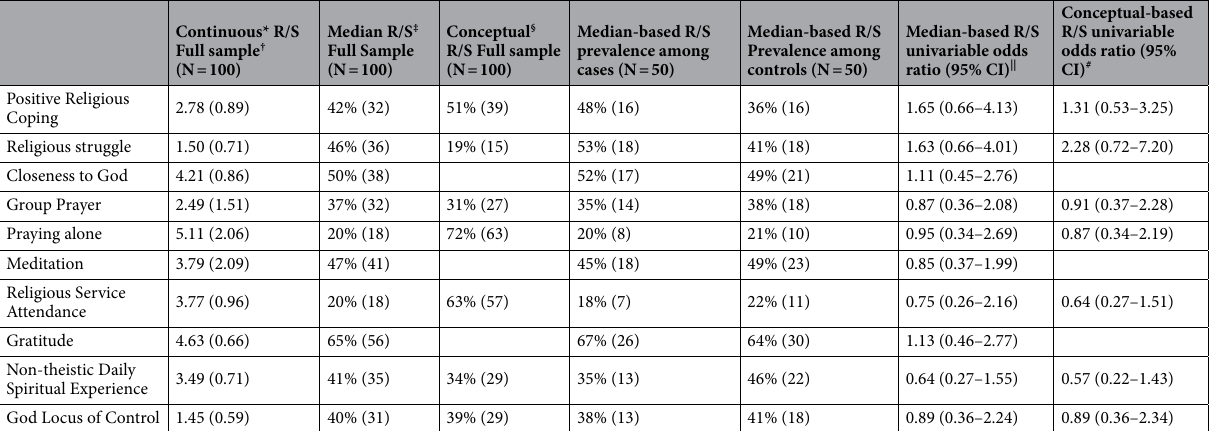
Table 4. Prevalence of R/S Variables and their Association with Incident CVD in the MASALA Study. *Mean (Standard Deviation). † Of the 100 subjects in the sample, depending on the R/S variable, 10 to 14 subjects do not have R/S data. ‡ R/S variables dichotomized at the median of the distribution of the continuous R/S variables (yes: above median). § R/S variables dichotomized into conceptually based R/S variables (yes: above threshold). || Univariable logistic regression where Incident CVD is the dependent variable, and the Median- based R/S variable is the independent variable. This is the odds ratio of Incidence of CVD above versus below median of the R/S variable distribution. # Univariable logistic regression where Incident CVD is the dependent variable, and the conceptually-based R/S variable is the independent variable. This is the odds ratio of Incidence CVD of above versus below conceptual threshold of the R/S variable distribution.